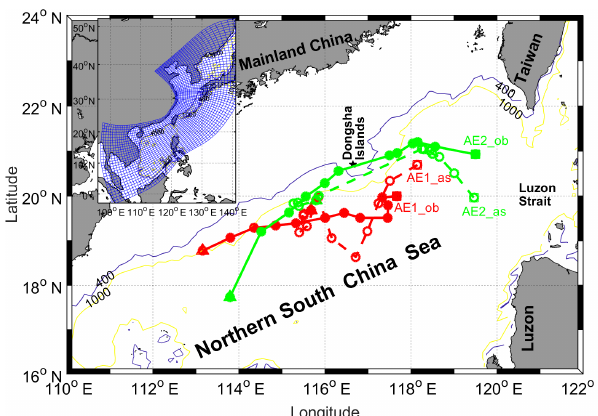
Figure 1. Bathymetry of the northern South China Sea. The blue and yellow contour lines are the isolines of 400 and 1000m, respec- tively. The solid black cross indicates Dongsha Islands. The migra- tion path of AE1 and AE2 in the NSCS during December 2003– April 2004 are shown. Solid (hollow) red dots and solid (dash) lines indicate weekly passing position and migration path of observation (assimilation) AE1. Solid (hollow) green dots and solid (dash) lines indicated weekly passing position and migration path of observa- tion (assimilation) AE2. The squares and triangles denote start and end positions, respectively. The model domain of CSCS (the inset panel), the curvilinear orthogonal model grid with 1 / 8–1 / 12 ◦ hori- zontal resolution (147 × 430) is denoted by the blue grid (at intervals of 10 grid cells